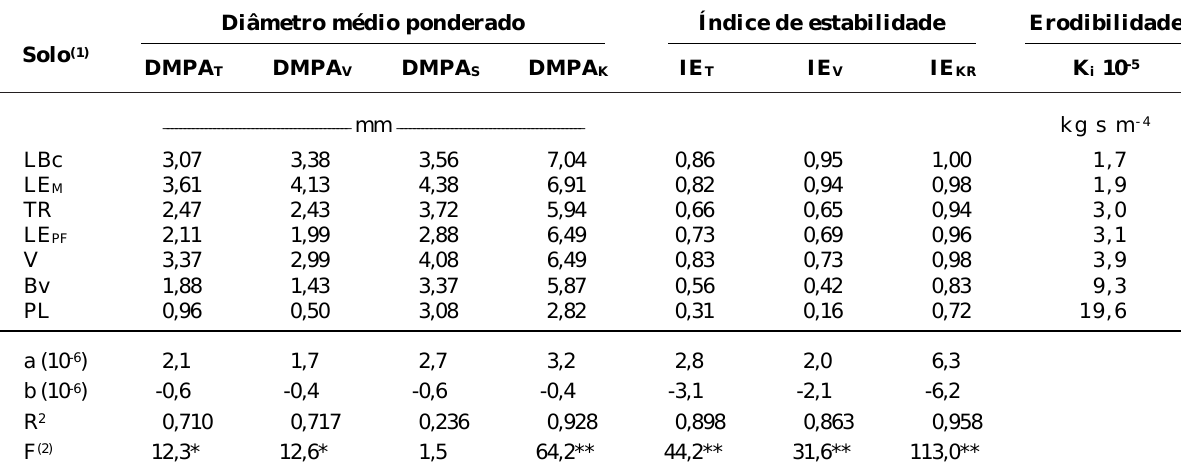
(1) LB = Latossolo Bruno Câmbico; LE = Latossolo Vermelho-Escuro de Marau; TR = Terra Roxa Estruturada; LE M Vermelho-Escuro de Passo Fundo; V = Vertissolo; Bv = Brunizém Vértico; PL = Planossolo. (2) O valor F calculado indica o grau de significância da correlação. * significativo para P < 0,05 e ** significativo para P < 0,01. ns = não-significativo P < 0,05.